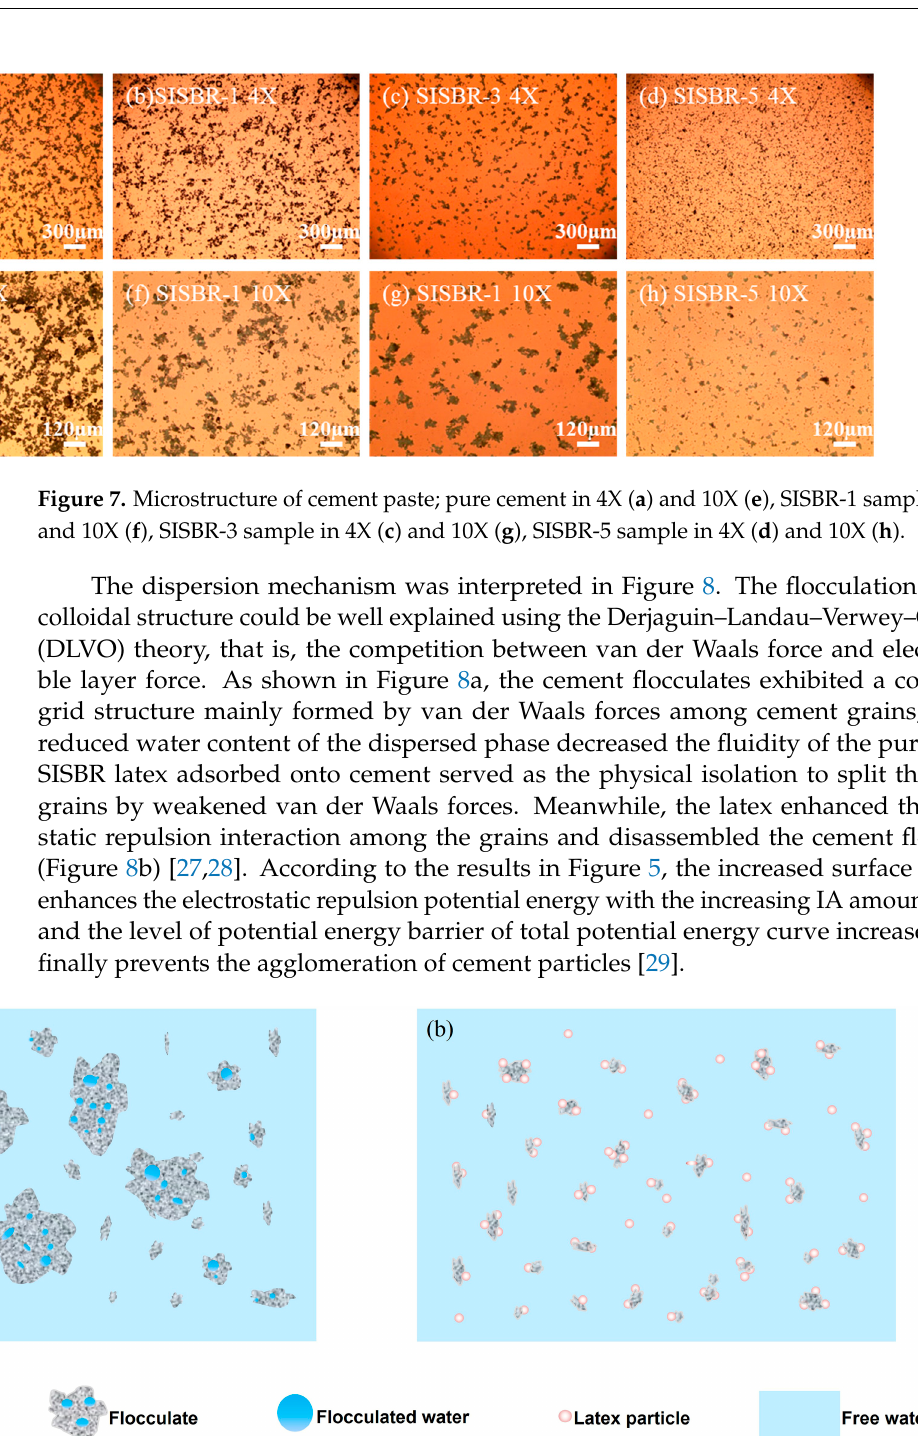
10 of 18 Figure 6. Fluidity behavior of the cement pastes with SISBR latex. 3.2.2. Optical Microstructure of Cement Slurry An optical microscope was used to examine the dispersing state of cement particles with latex powder [25,26]. Figure 7a–d presents the microscope images of pure cement paste magnified four times, cement paste with SISBR-1 latex, SISBR-3 latex, and SISBR-5 latex, respectively. Figure 7e–h presents the microscope images magnified ten times. As clearly indicated from the figures, there were considerable flocculation structures with different sizes for the pure cement paste (Figure 7a), due to the attraction of opposite charge generated by cement hydration and van der Waals force between cement particles.